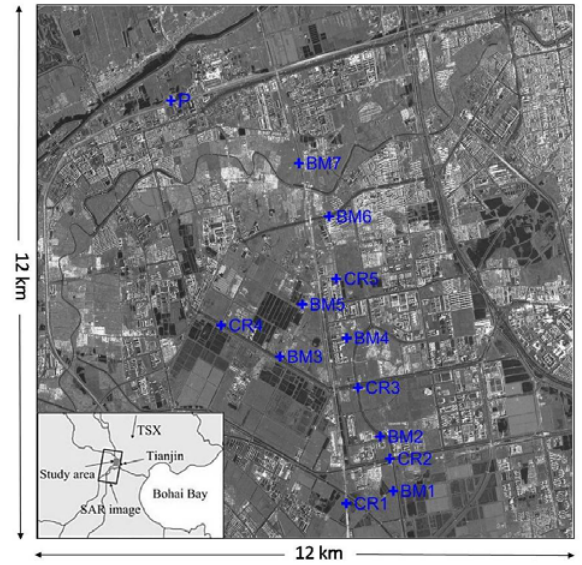
Figure 2. The location map of the study area and the amplitude image averaged from 23 TSX images.